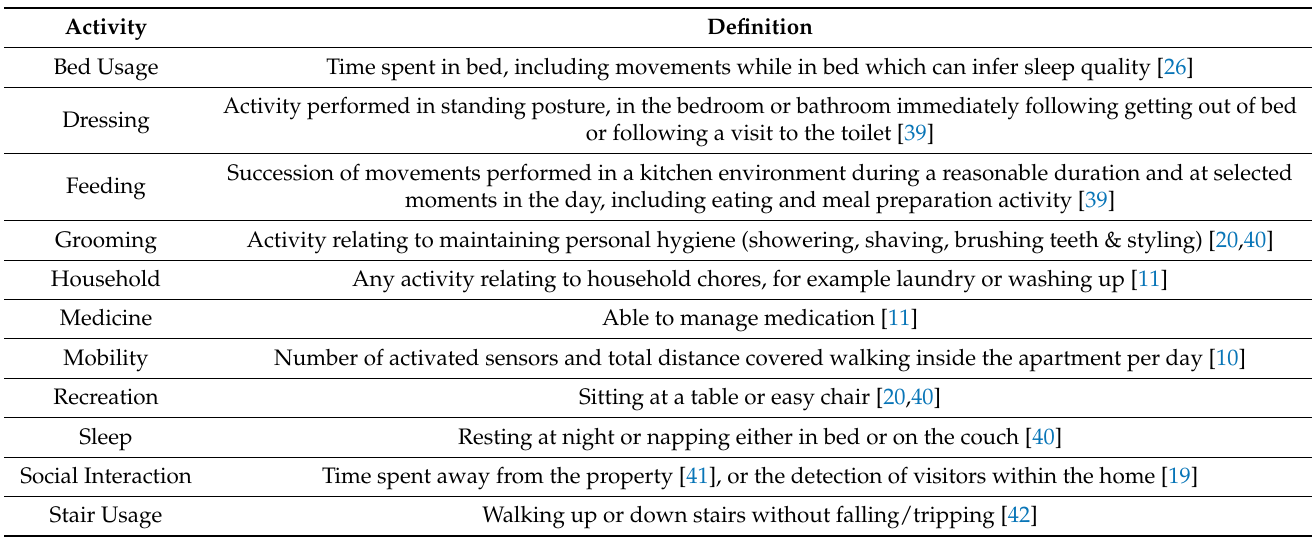
Table 3. Definitions of the Activities of Daily Living (ADL) recognised by the identified